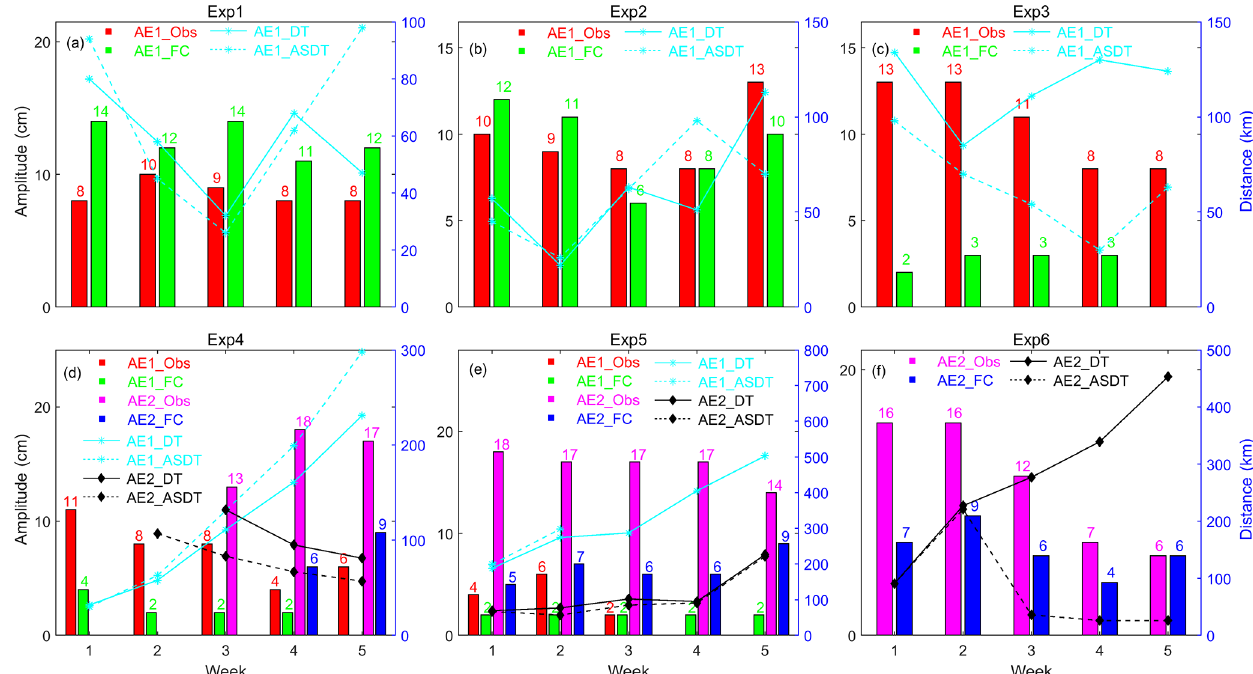
Figure 14. The amplitude of AE1 and AE2 derived from observation SLA and the six forecast SLA, and distance of eddy centers between the observation, assimilation, and forecast SLAs, respectively. The red and green histograms indicate the AE1 amplitudes from observation and prediction, respectively. The pink and blue histograms express the AE2 amplitudes from observation and prediction, respectively. The cyan star and solid (dashed) line show the distance of the center between observation and prediction (assimilation) AE1. The black diamond and solid (dashed) line show the distance of the center between observation and prediction (assimilation)